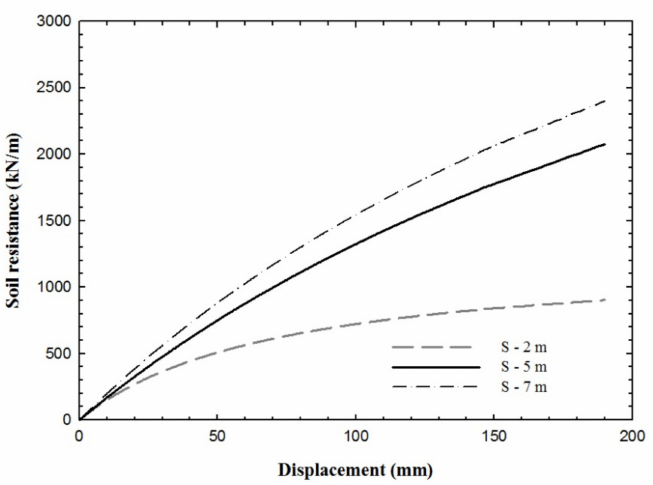
Figure 7. Experimental static p-y curves at depths of 2, 5, and 7